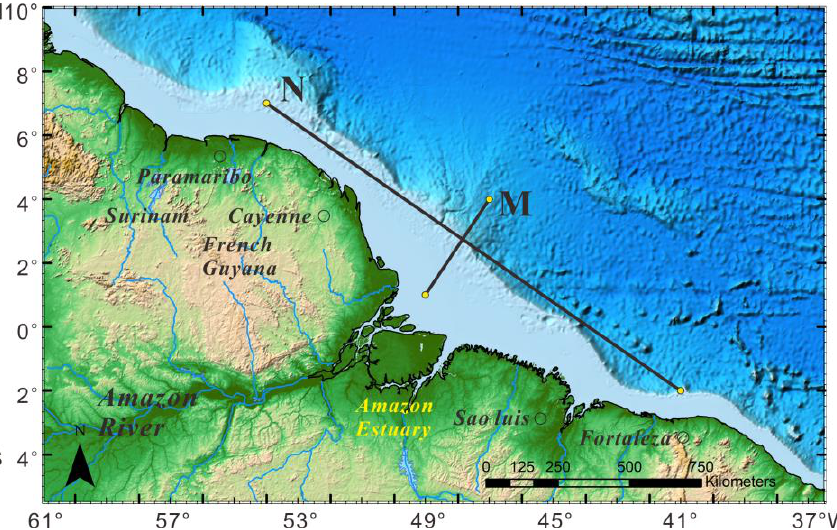
Figure 1. Bird’s-eye-view image of the study area in the Amazon estuary (ETOPO1 Global Relief Model, https://www.ngdc.noaa.gov/mg/global/global.html (accessed on 1 February 2021)). M and N are two transects perpendicular to and parallel to the shoreline, respectively, which will be discussed in the following sections.